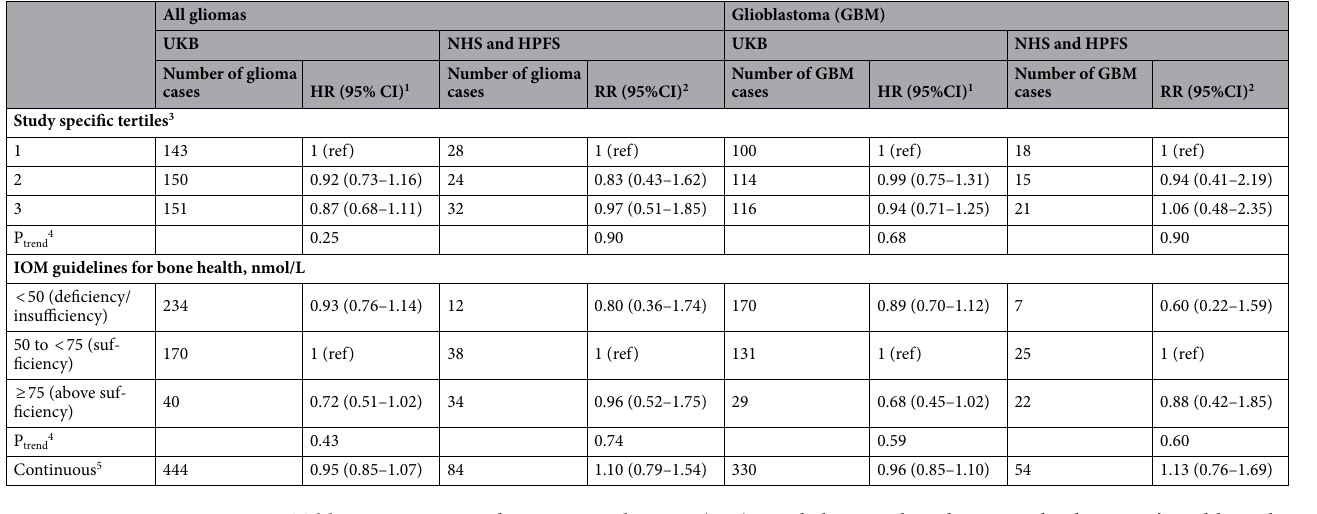
Table 2. Associations between circulating 25(OH)D and glioma risk in the UK Biobank, Nurses’ Health Study, and Health Professionals Follow-Up Study. 25(OH)D 25-hydroxyvitamin D, CI confidence interval, HPFS Health Professionals Follow-Up Study, HR hazard ratio, IOM Institute of Medicine, NHS Nurses’ Health Study, RR risk ratio, UKB United Kingdom Biobank. 1 Adjusted for sex (male, female), age (continuous), race (non- white, white), month of blood collection (continuous), body mass index (continuous), and smoking status (never, past, current). 2 In addition to conditioning on matching factors in the NHS and HPFS year of birth, fasting status, month of blood collection, and race), adjusted for body mass index (continuous) and smoking status (never, past, current). 3 Median serum 25(OH)D for each tertile in the UKB: 26.91, 46.43, 68.67 nmol/L; median plasma 25(OH)D for each tertile in the NHS and HPFS: 47.29, 69.49, and 87.07 nmol/L. 4 The p-value for linear trend corresponds to the p-value of the ordinal variable constructed by assigning the median value of each category to all participants in that category. 5 Results for the continuous analyses are given for a 25 nmol/L